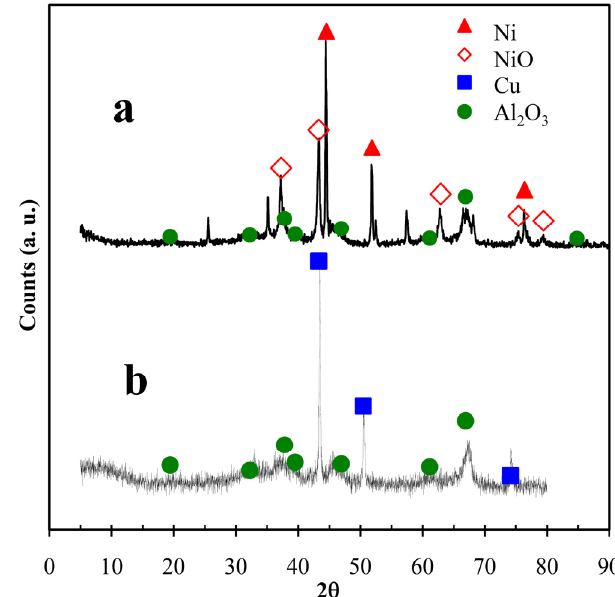
Figure 2. XRD patterns of prepared powders of ( a ) Ni; and ( b ) Cu particles on